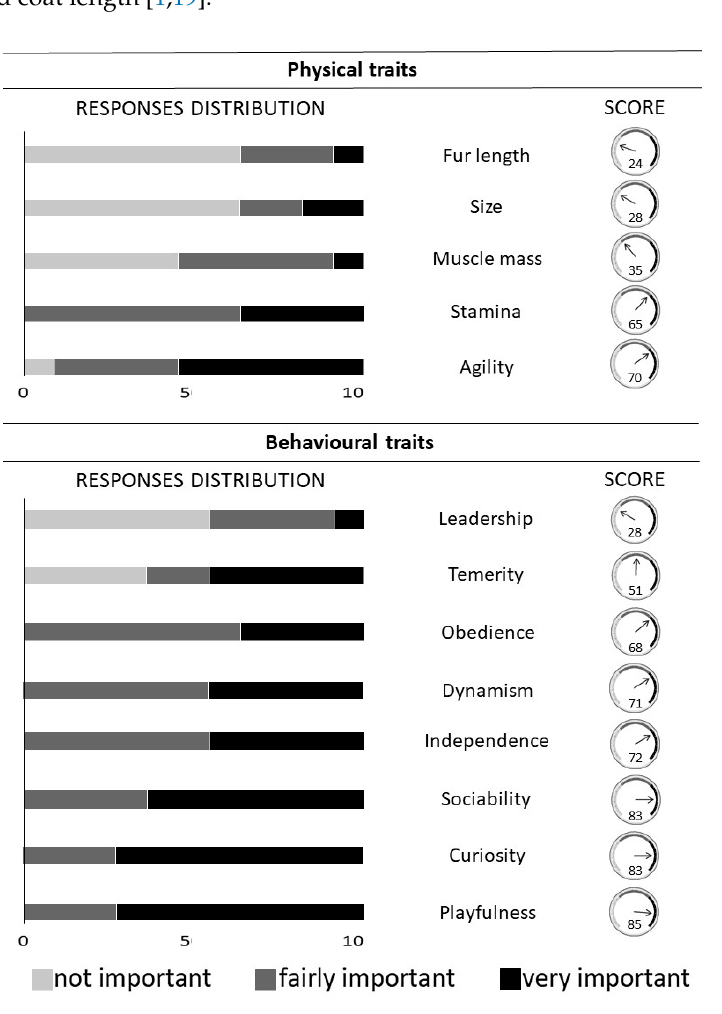
Figure 2. Handlers’ estimation of the importance of the physical and behavioral traits that must be considered during the selection of human remains detection dogs. The response distribution describes the percentage of handlers (out of 50) that estimate the importance of each trait (not important, fairly important, very important). The score estimates the importance of the traits during the selection according to equation 1.